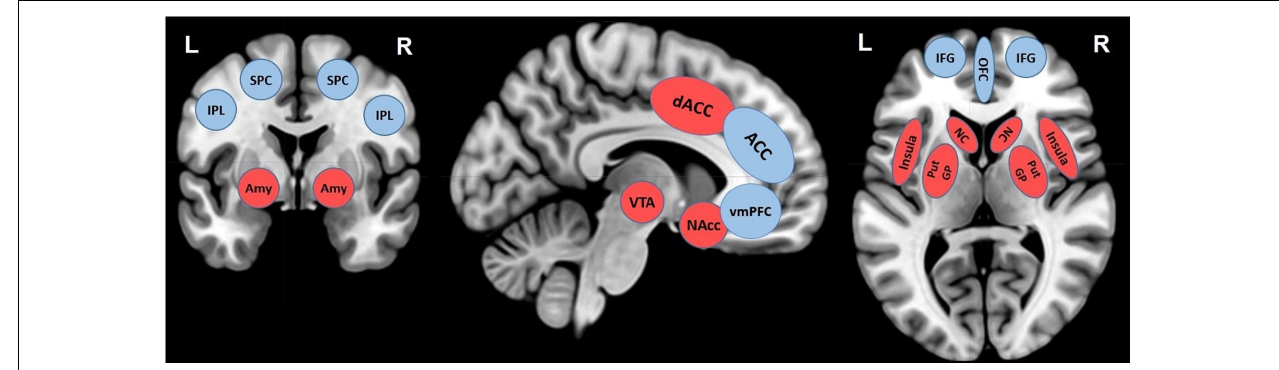
FIGURE 1 | Overview of main brain regions reported in neuroimaging studies investigating structural and functional brain alterations associated with screen time in adolescence. The MRIcron software package (Rorden et al., 2007) was used to create brain renderings on a standard T1 template for illustrative purposes of brain areas involved in control (blue circles) and reward systems (red circles): ventro-medial prefrontal cortex (VMPFC), dorsal anterior cingulate cortex (dACC), anterior cingulate cortex (ACC), amygdala (Amy), putamen (Put), caudate nucleus (CN), inferior frontal gyrus (IFG), insula, nucleus accumbens (NAcc), ventral tegmental area (VTA), orbitofrontal cortex (OFC), superior parietal cortex (SPC), inferior parietal lobule (IPL). Lateralization, R, right; L,